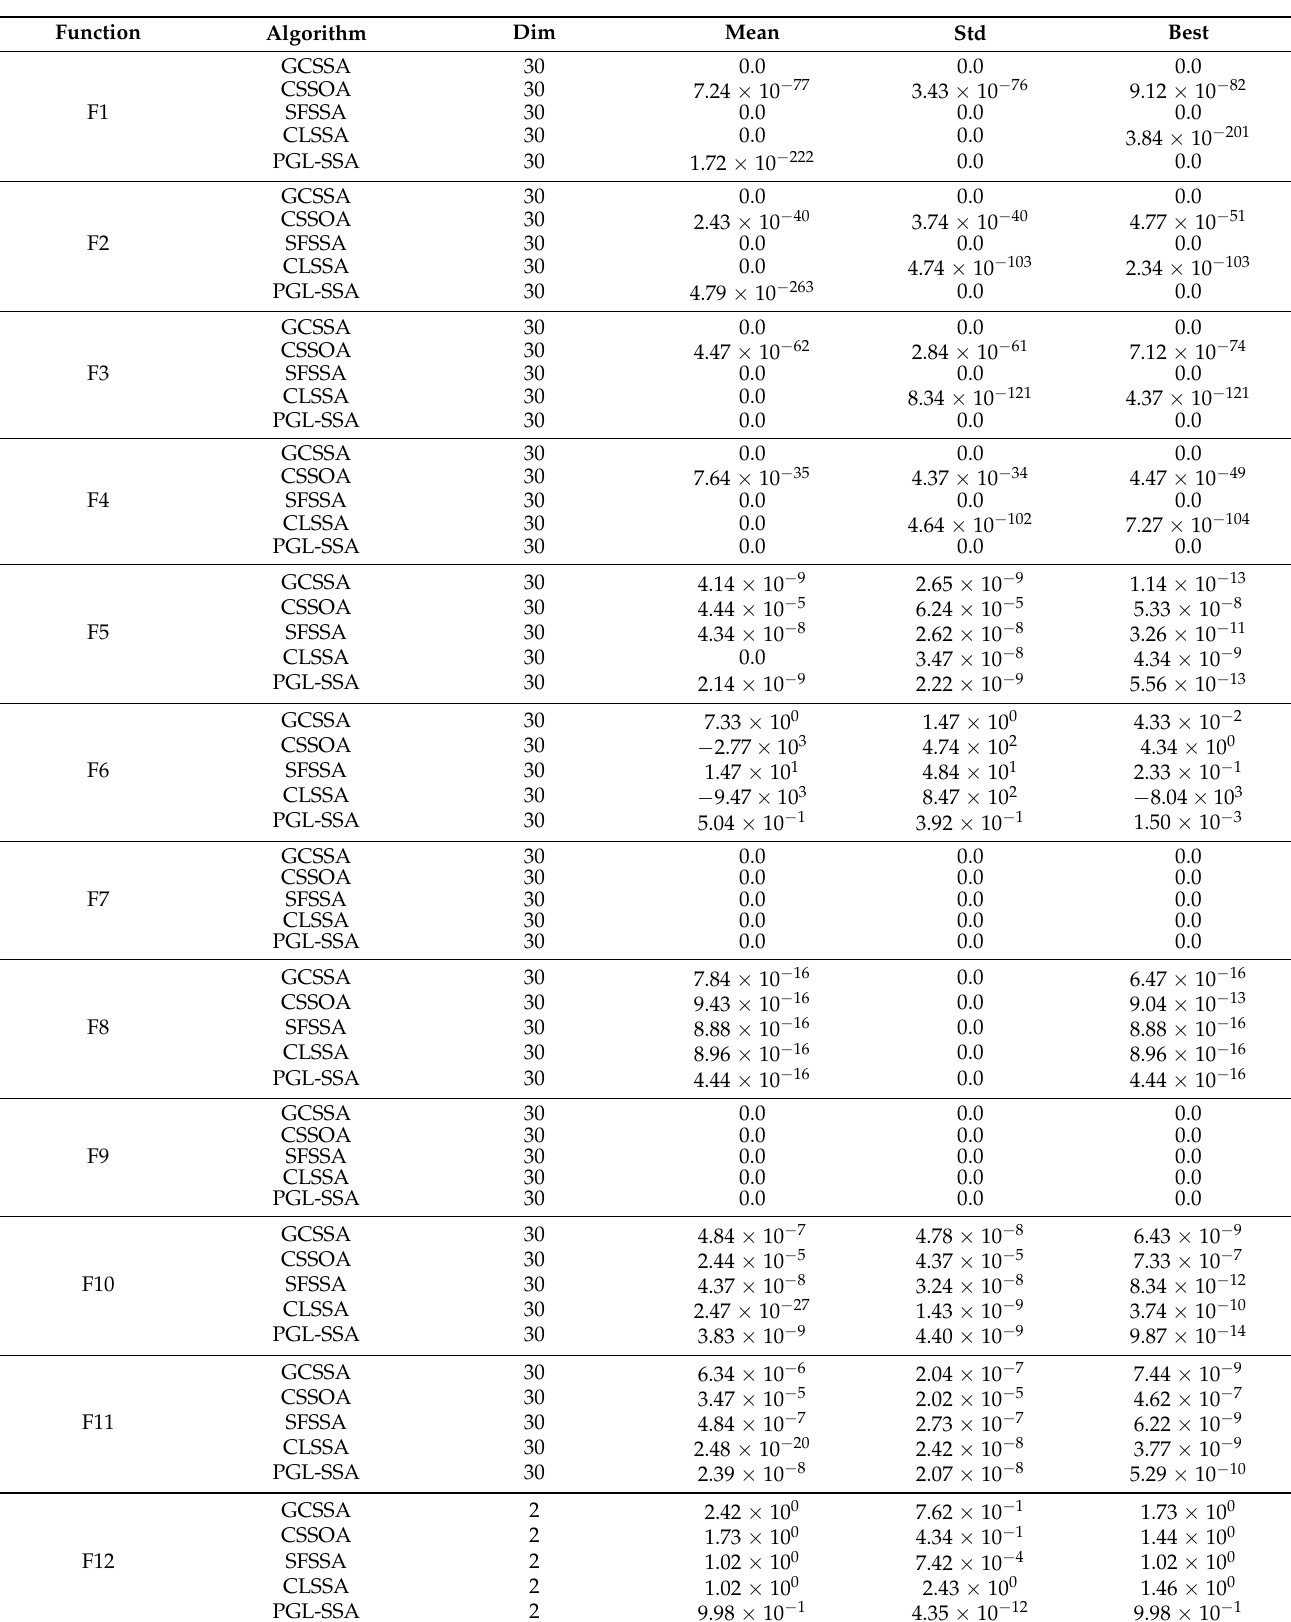
Table 5. Results and comparison of different improved algorithms for 21 benchmark